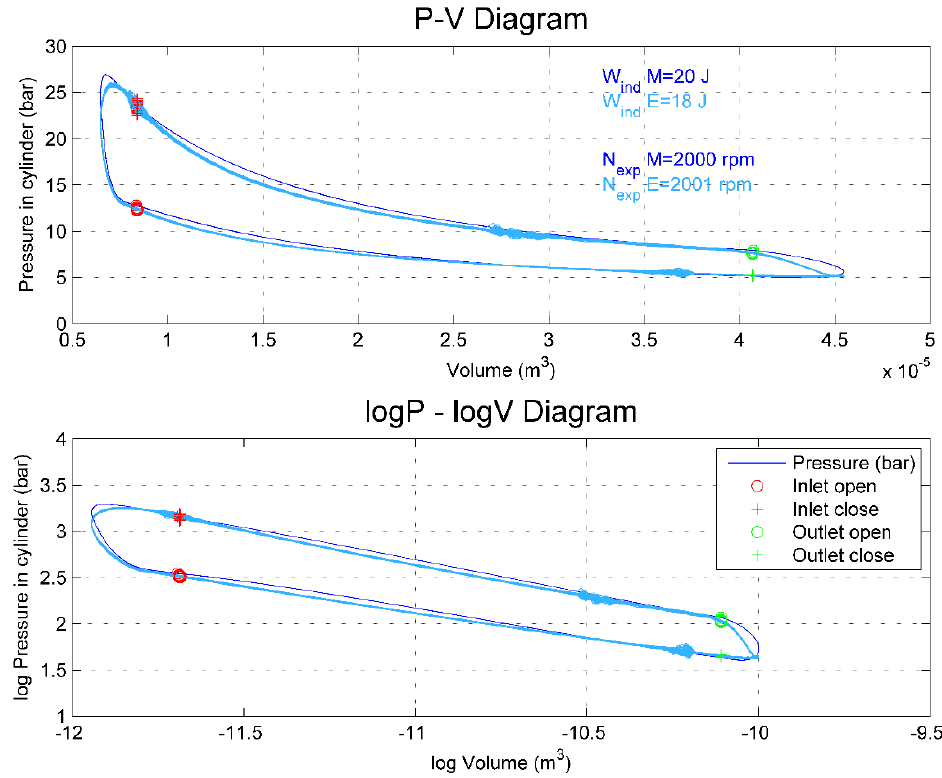
Figure 17. P - V Diagram 2000 rpm.